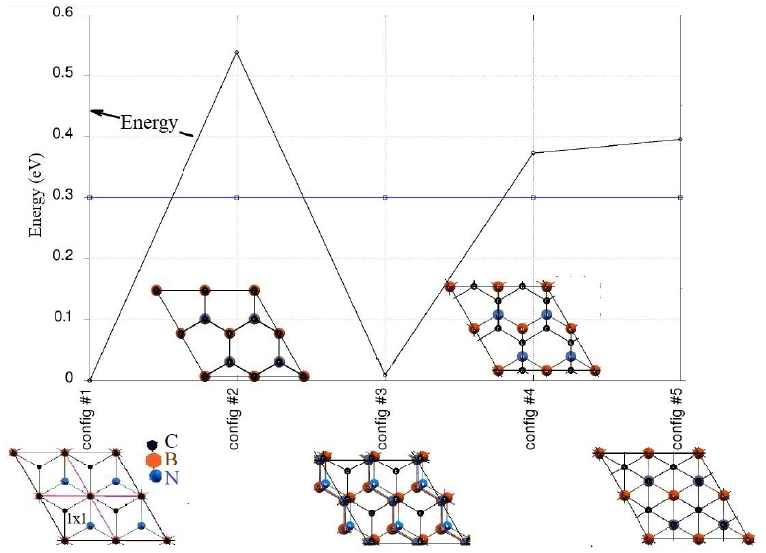
Figure 3. Total energy as a sub-configuration function of A-lattice (the minimum energy serves as a reference).